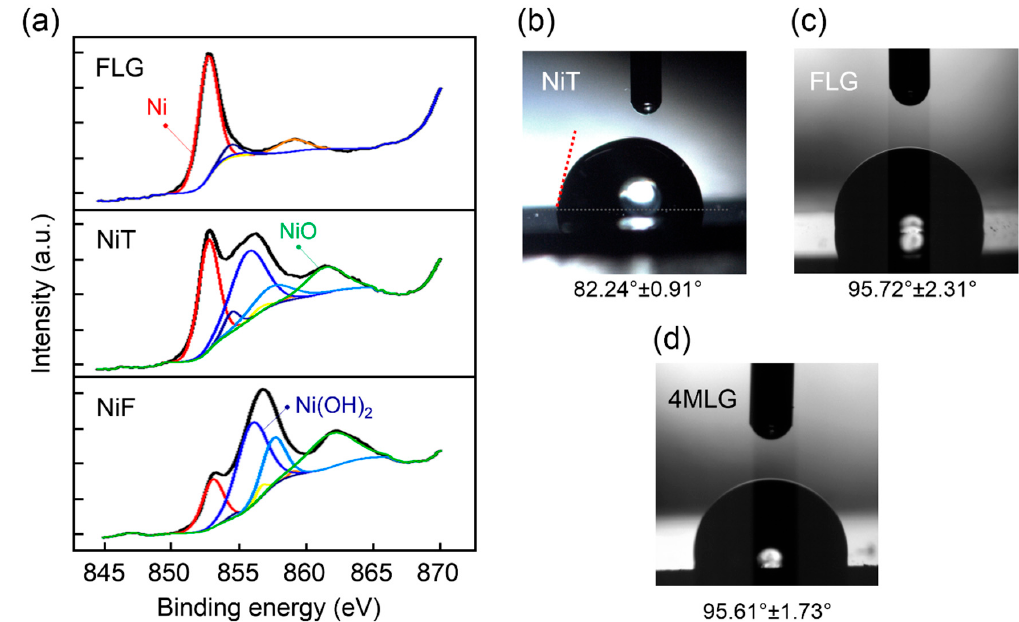
Figure 2. Surface composition and hidrophobicity of coated and uncoted Ni samples. ( a ) XPS Ni 2p 3/2 spectra of coated and uncoated Ni, including peak fitting to identify Ni (red, yellow and orange), NiO (green) and Ni(OH) 2 (blue) contributions. This allows the identification of FLG control sample (NiT). Images of contact angle measurements using Milli-Q water in contact with ( b ) NiT; ( c ) FLG and ( d ) 4MLG.